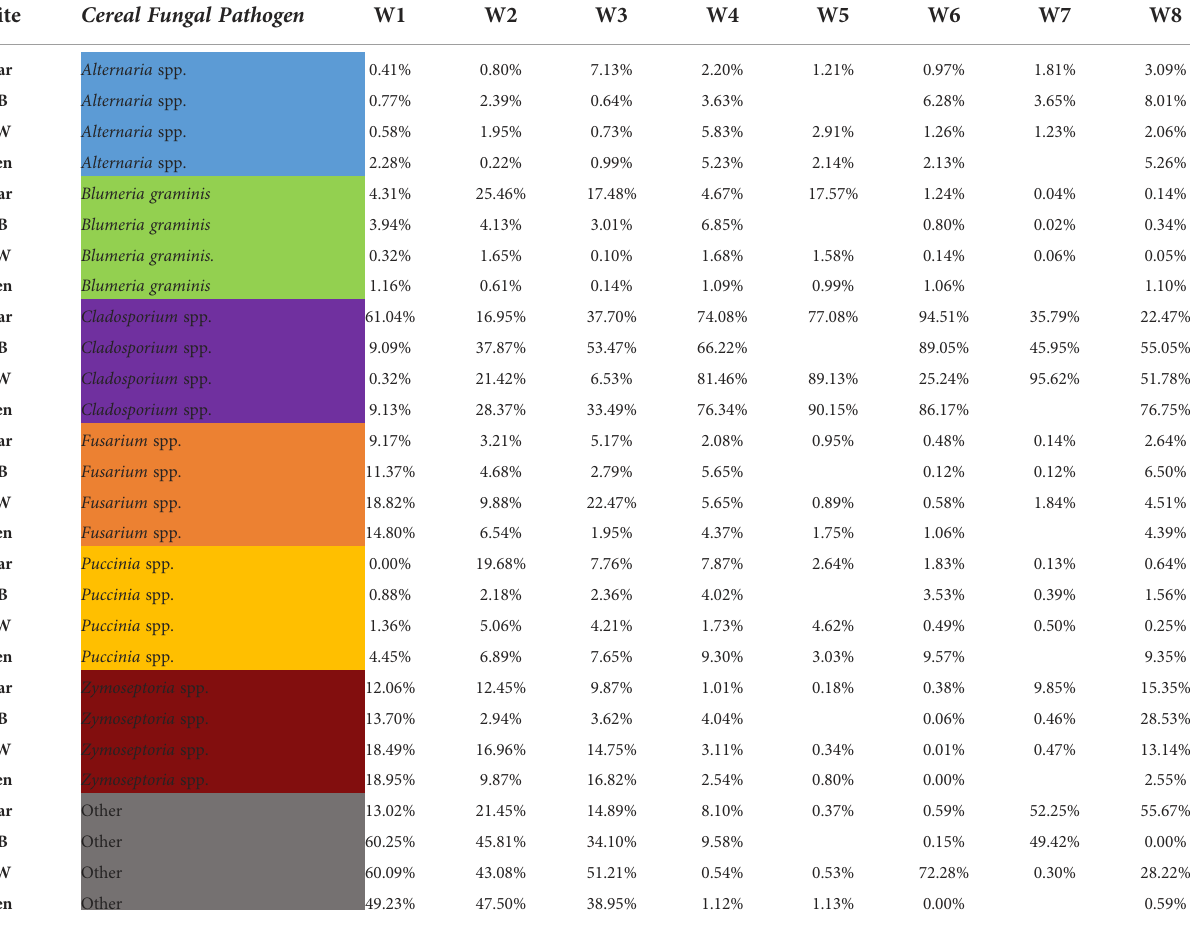
TABLE 1 Microscopy results displayed as weekly, week 1 (W1) to week 8 (W8) percentage of fungal cereal pathogen abundances. Site Cereal Fungal Pathogen